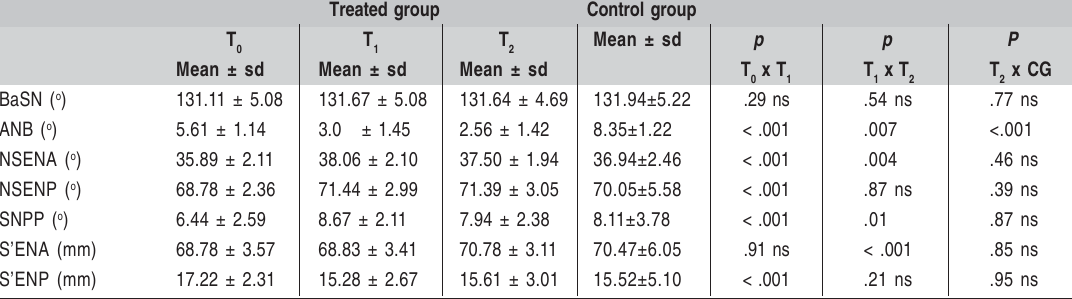
), at the end of treatment (T ) and with a minimum of 5 years post-retention (T 0 1 , T and T and in the control group (n=17). 0 1 2